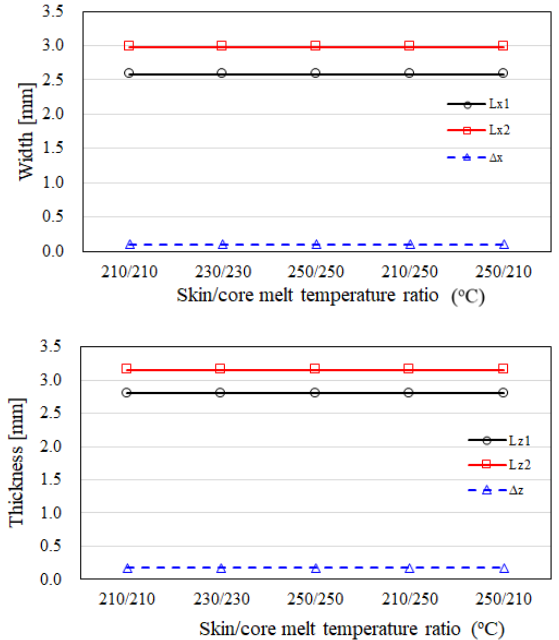
Figure 10. The dimension variation of the CSC structure for different melt temperature effects.